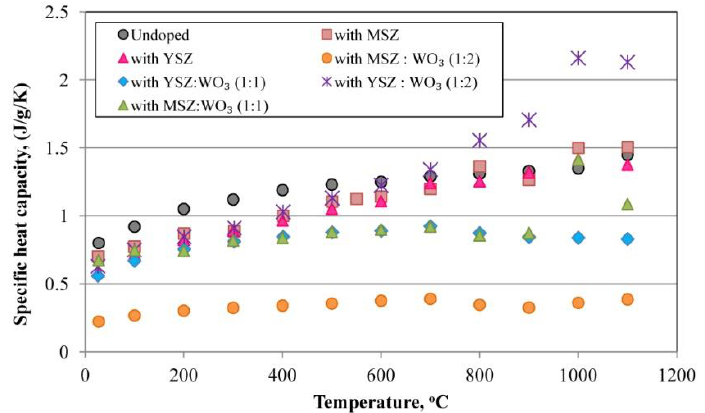
Figure 9. Specific heat capacity of the samples.